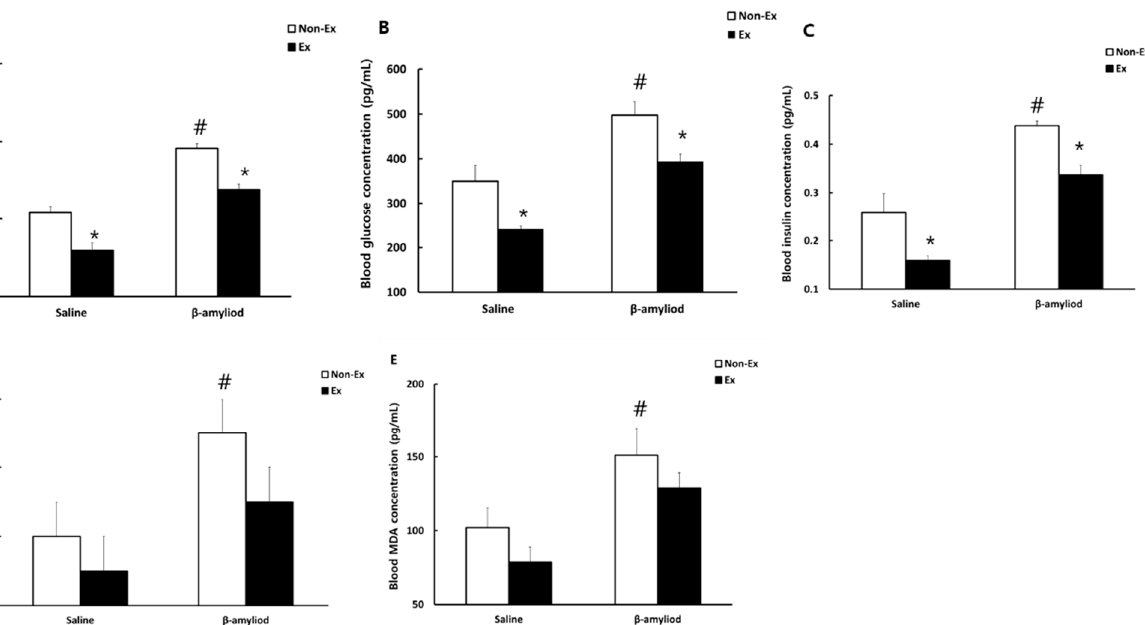
Figure 5. Comparisons of blood concentrations of ( A ) β -amyloid, ( B ) glucose, ( C ) insulin, ( D ) CRP, and ( E ) MDA after the 12-week intervention. (* p < 0.05 Significant difference as compared to Non-Ex group; # p < 0.05 Significant difference as compared to Saline group).